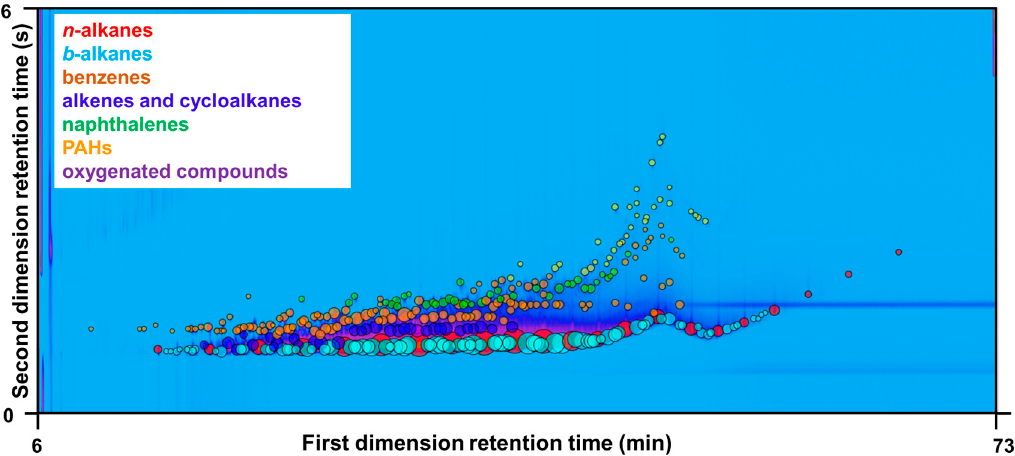
Figure 1. A typical chromatogram of 0# diesel fuel (No 1). The blob size is commensurate with its mass percentage. Column bleedings are excluded from the blobs.